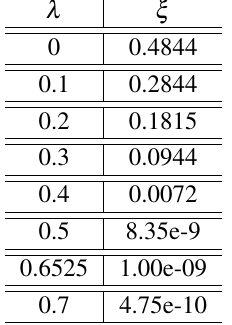
Table 1. Different values for λ on